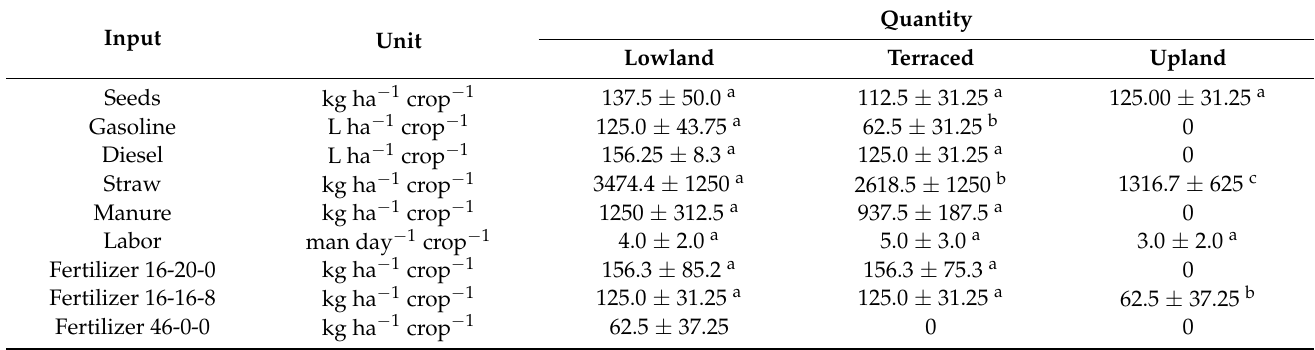
Table 1. Input inventory of lowland, terraced, and upland rice systems during 2020–2022 (mean ± Table 1 . Input inventory of lowland, terraced, and upland rice systems during 2020 – 2022 ( mean ± standard standard deviation ).